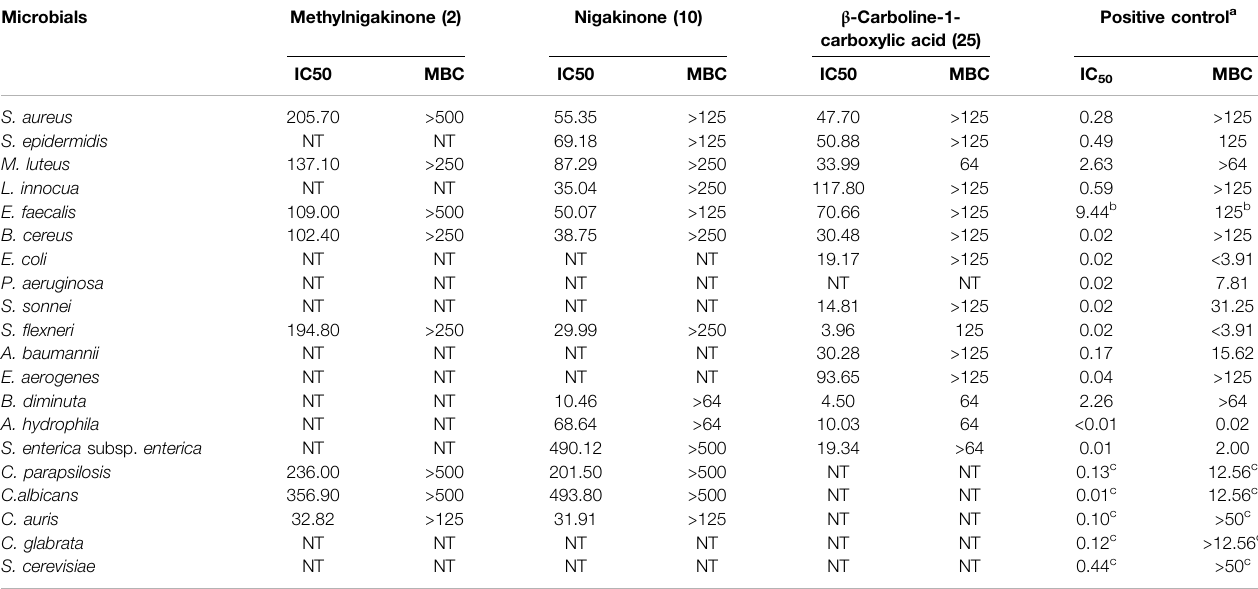
TABLE 3 | Antimicrobial activity ( μ g/ml) of three β -carbolines.